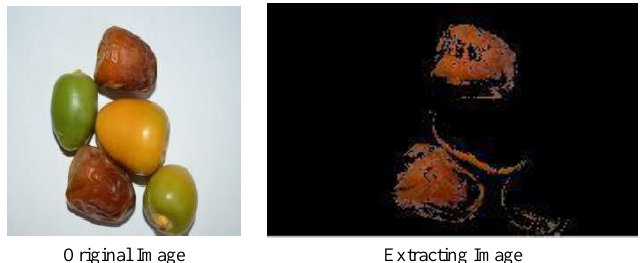
Figure 4. Extracting image using Threshold